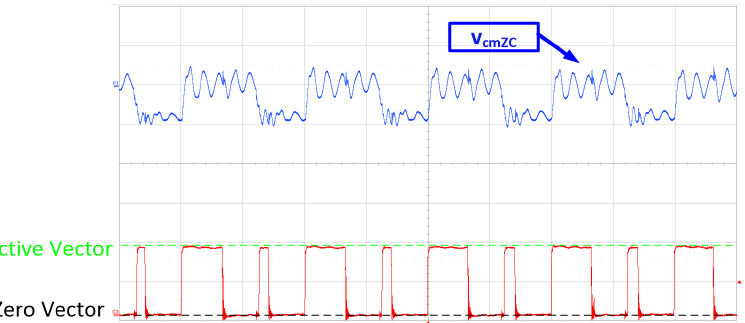
Figure 25. Experimental waveforms. v cmZC (upper trace, 100V/div) and States (lower trace). The time division is 20 µ s/div.